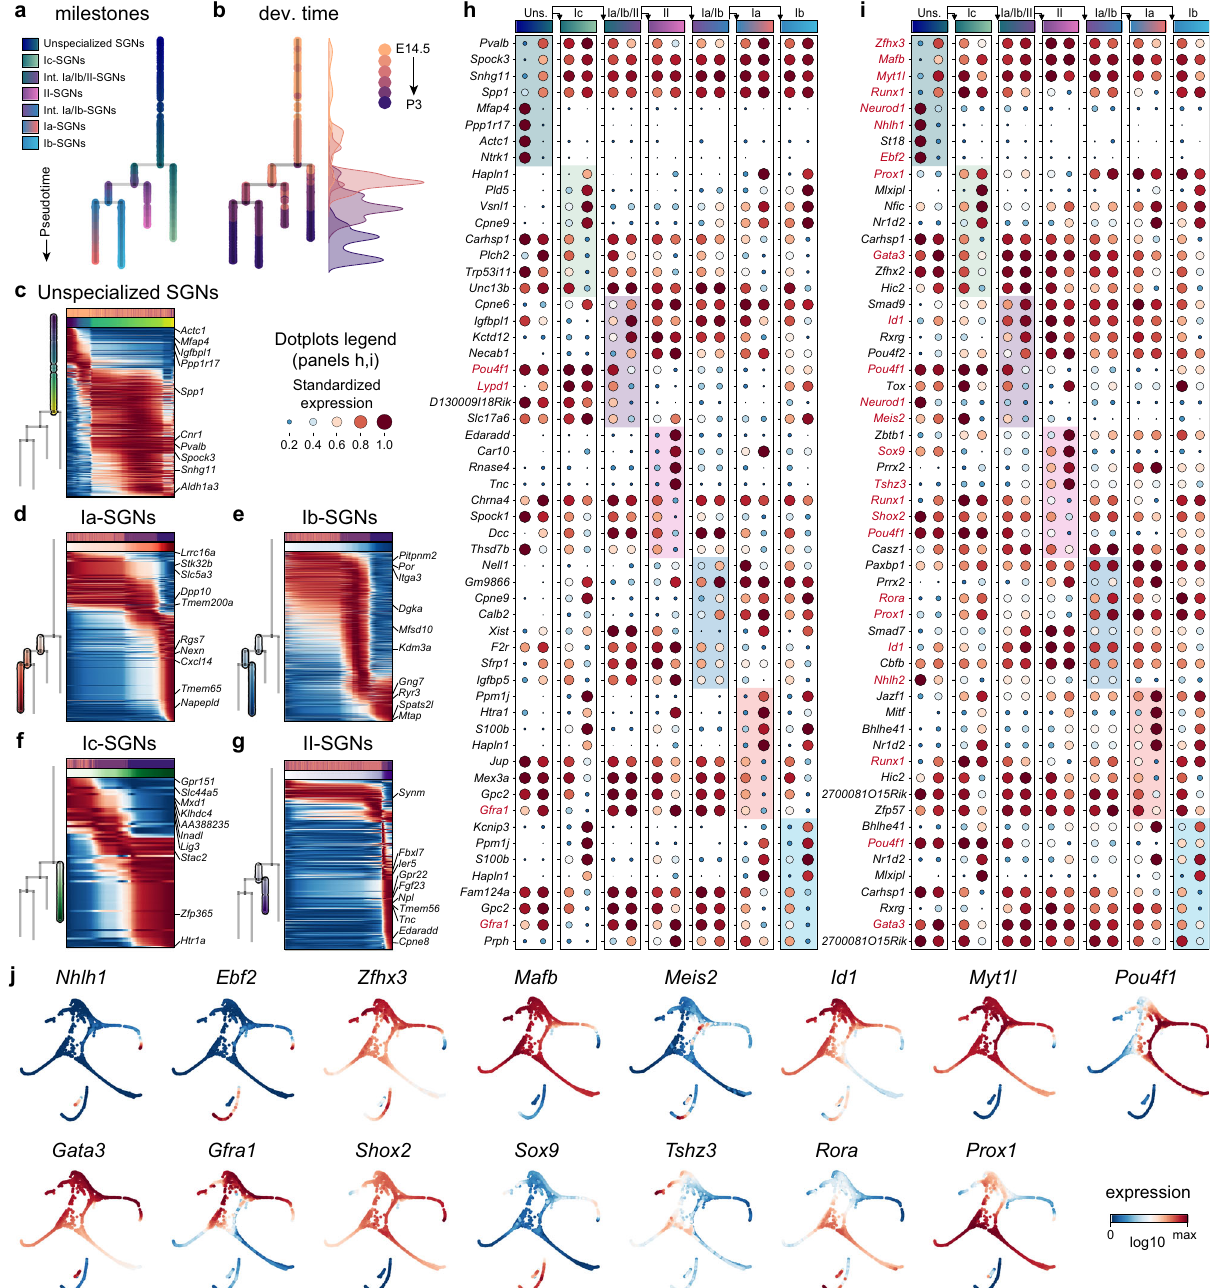
Fig. 2 Molecular trajectories of developing SGN cell types. a Dendrogram recapitulating the branched trajectory of the developing SGNs based on the transcriptional similarity of pseudotime-ordered cells. b Normalized fraction of cells corresponding to each time point of collection across pseudotime, showing that pseudotime is aligned with age. c – g Heatmaps representing overview analysis of the different trajectories, together with the top ten upregulated genes along the differentiation of each branch. h , i Genes predicted to be likely involved in cell state and cell type divergence along the diversi fi cation tree; the top 4 up- and 4 downregulated genes ( h ) and transcription factors ( i ) are shown for each branch/cell state, as de fi ned in a . j Plots showing different marker genes [in MAGIC imputed log10(fpm) expression] delineating different SGN subtype trajectories. Genes referenced through the text are highlighted in red. The color bars at the top indicate cell states as in a . Data in c – g are expressed in minimax normalized fi tted log10(fpm). Dev. developmental, Int.